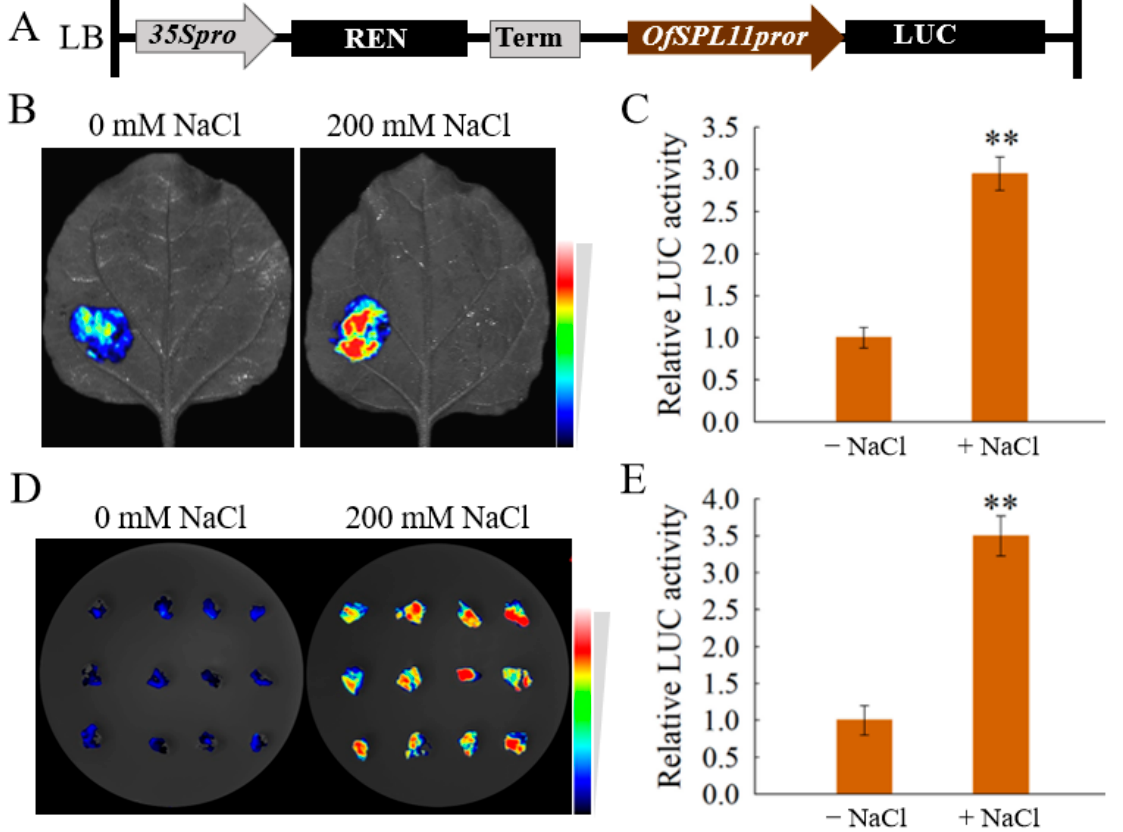
Figure 5. Salinity directly activates the activity of proOfSPL11 . ( A ) Schematic representation of OfSPL11 pro:LUC; ( B , C ) the activity of proOfSPL11 was activated in tobacco leaves; ( D , E ) the activity of proOfSPL11 was activated in callus of Osmanthus fragrans . Each experiment had three biological replicates. ** p < 0.01 were used to determine statistical